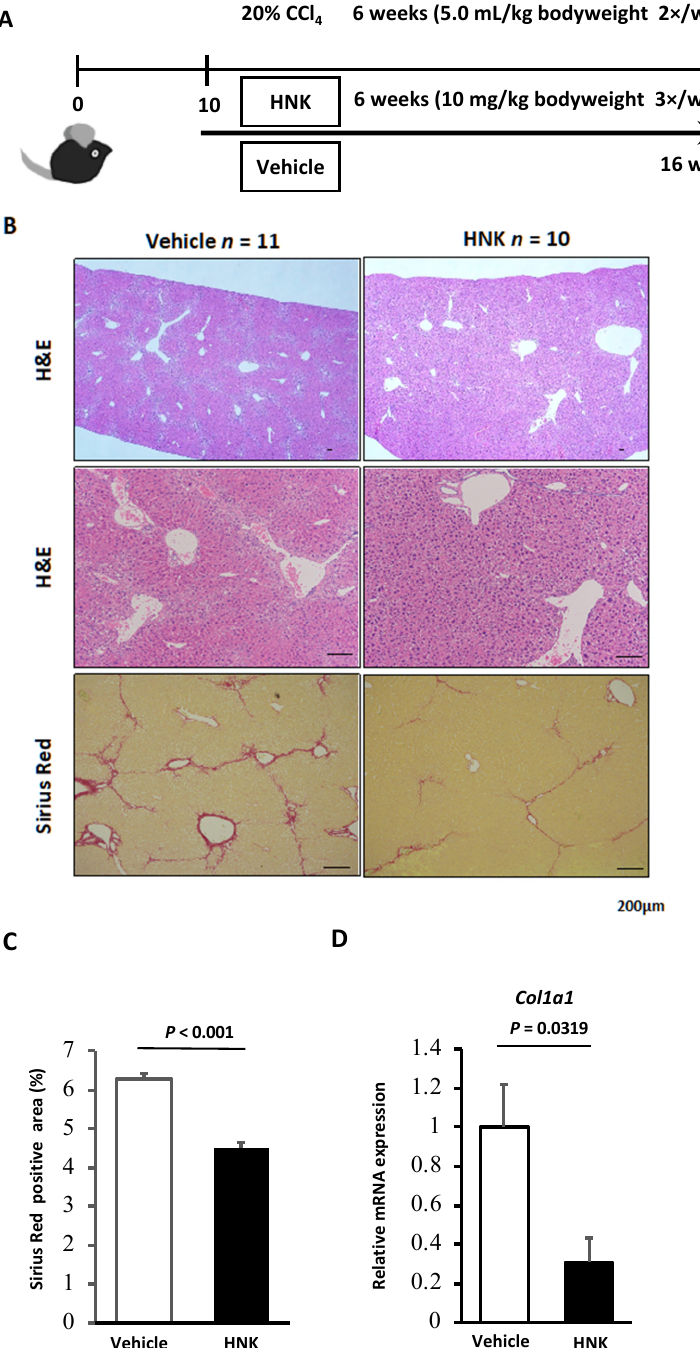
Figure 1. Honokiol (HNK) treatment attenuates fibrosis development in mice with CCl 4 -induced liver injury. WT mice were injected with 20% CCl 4 at 5.0 mL/kg body weight twice a week for 6 weeks (from 10 to 16 weeks of age). HNK was dosed at 10 mg/kg body weight or vehicle control administered three times per week on a day without CCl 4 injection for the same six weeks. Liver injury and fibrosis were assessed by H&E staining, Sirius-Red staining, and mRNA expression lev- els. ( A ) Schematic of CCl 4 -induced mouse liver injury model. ( B ) Representative microphotographs of liver sections stained with HE and Sirius Red. The bottom row of HE stained images are enlarged images of the same specimens as the top row, respectively. Scale bars represent 200 μ m. ( C ) Sirius Red positive areas (%) quantified by BZ-X800 Analyzer. ( D ) Relative mRNA expression levels of